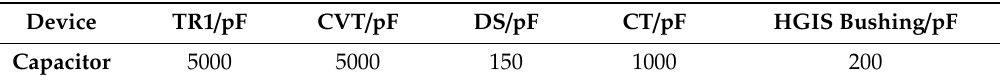
Table 5. Equivalent capacitor of some equipment.